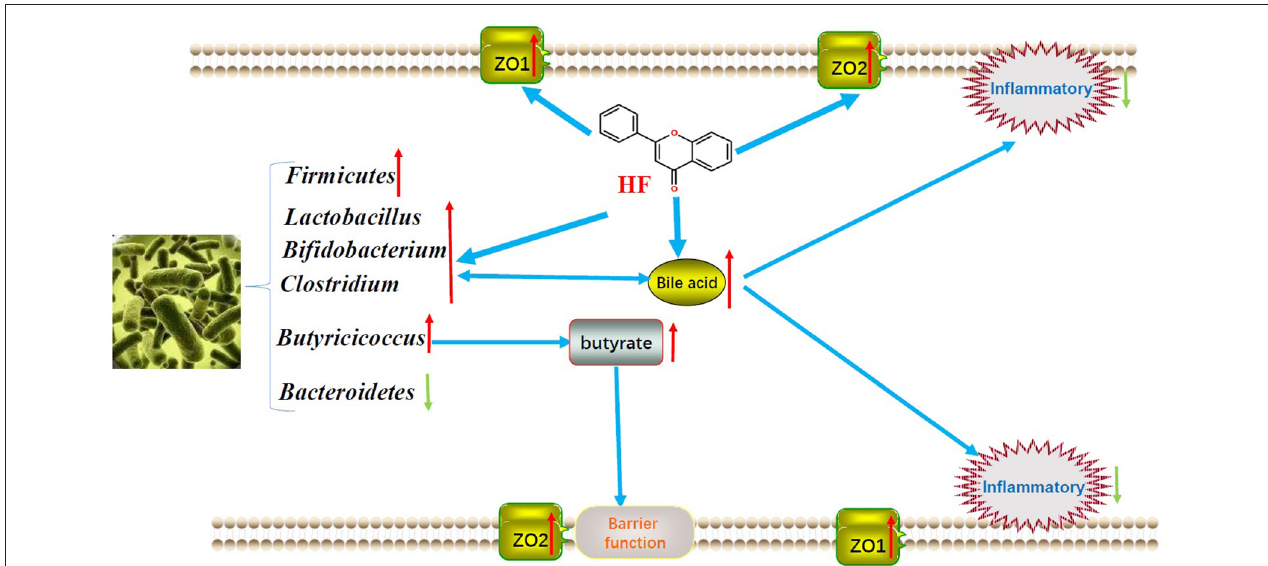
FIGURE 4 | Underlying mechanism of honeycomb flavonoids on the intestinal absorption of